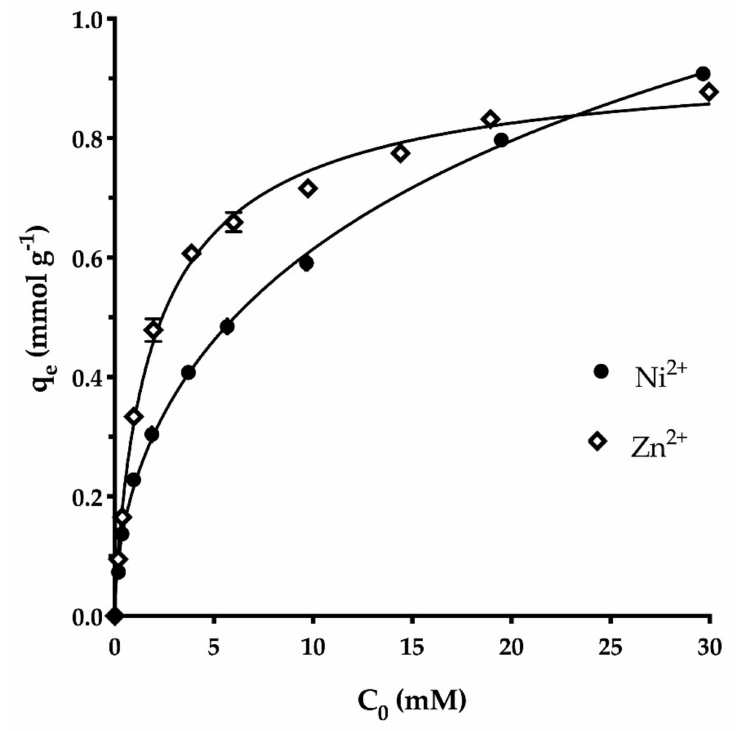
Figure 2. The e ff ects of initial metal concentration on Ni 2 + and Zn 2 + biosorption from aqueous solutions in single metal